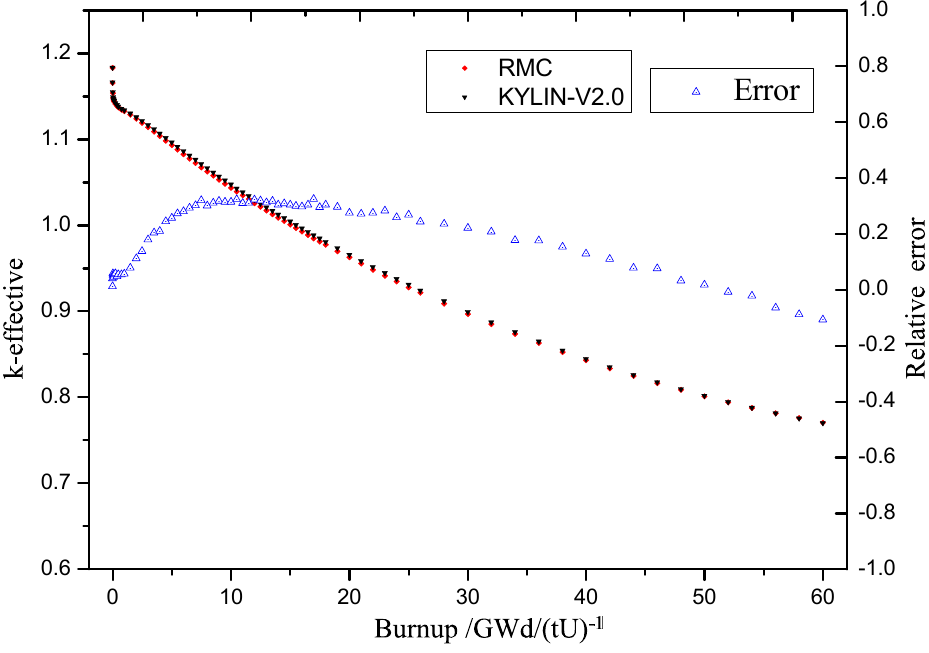
Figure 8. K-effective vs burnup for VERA 2B fuel